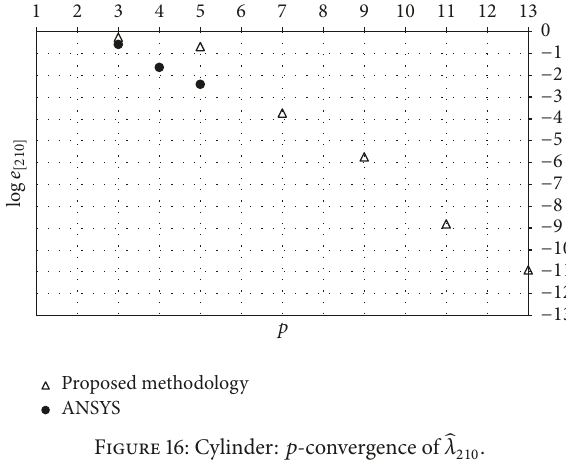
Figure 13: Cylinder: